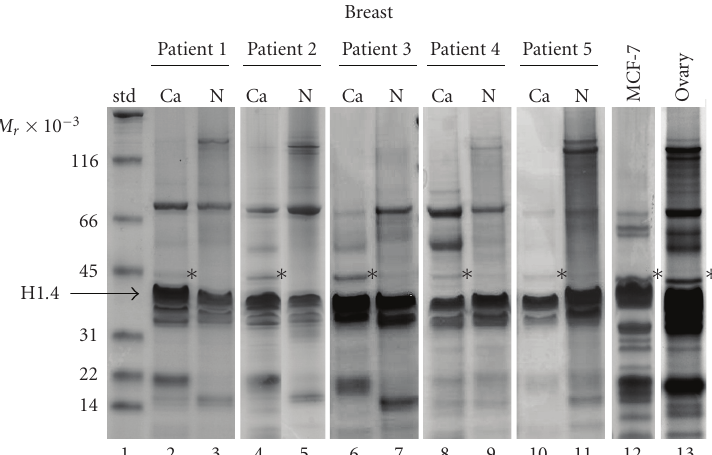
Figure 1: NUCKS is highly overexpressed in breast cancer. Lanes 2–11: Protein extracts from five pairs of tissue, each pair matching the individual patient, of normal breast (N) and invasive ductal carcinoma GII (Ca) were separated by SDS-PAGE and stained with Coomassie. Lanes 1, 12, and 13 : molecular weight standard and proteins extracts of MCF7 cells and an ovarian tumor, respectively. Asterisks indicate the position of NUCKS band. M r : relative molecular weight. The band of linker histone H1.4 (arrow), a highly abundant housekeeping protein, serves a “gel loading” control. Its intensity is similar in lanes of normal breast, IDC, and MCF7 cells lysates. Identity of the H1.4 band was confirmed by mass spectrometry (Figure 1).